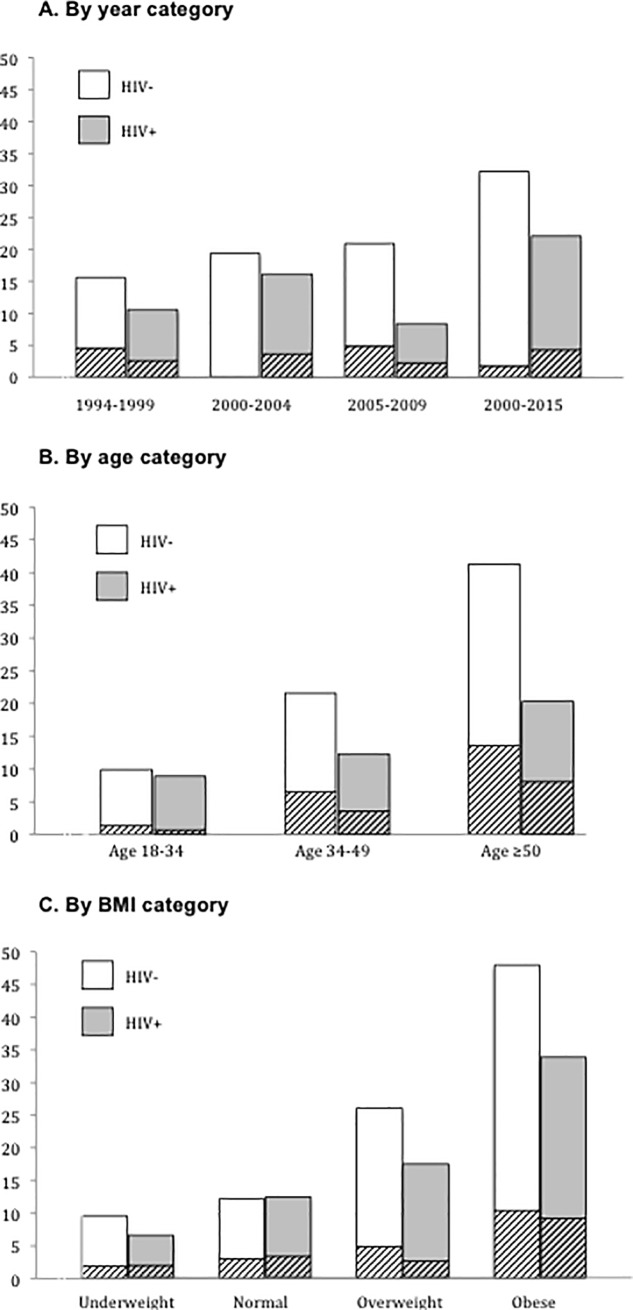
Prevalence (%) of hypertension among HIV-positive and HIV-negative subjects.Fig 1A. X-axis: year category; Fig 1B. X-axis: age category; Fig 1C. X-axis: BMI category. For all figures, Y-axis = prevalence of HTN (SBP ≥140 or DBP ≥90) and striped portions indicate subset with stage 2 HTN (SBP ≥160 or DBP ≥100).